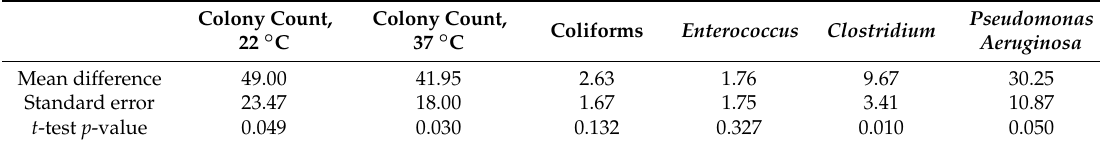
Table 4. Paired t -test results.